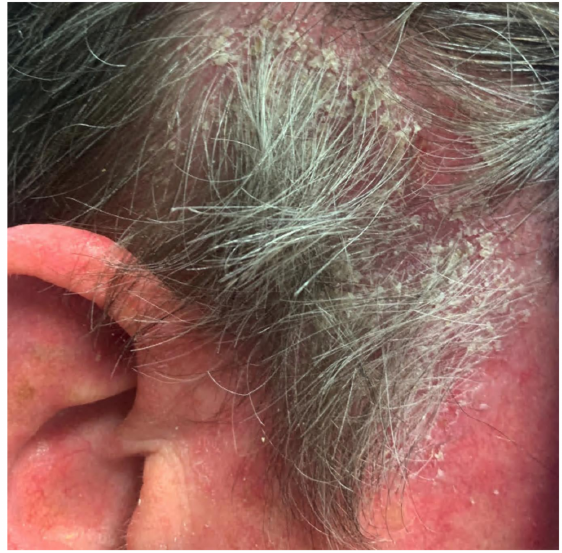
Figure 3. Pemphigus foliaceus. Thin erosions with bran-like scale on the scalp.